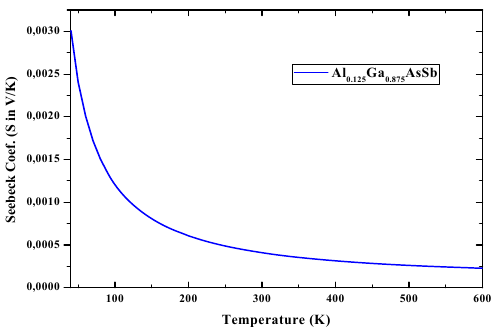
Figure 5. Seebeck coefficient (S) of AlGaAsSb nanostructured material within 0 − 600°K range .